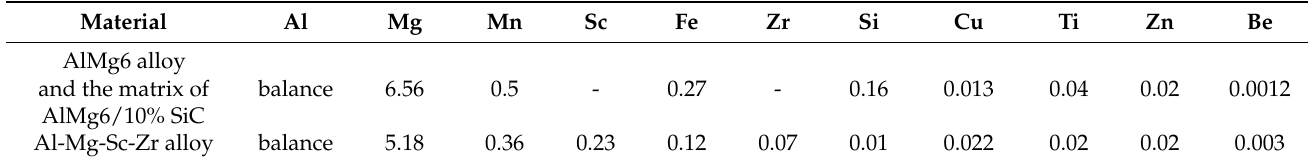
Table 2. Chemical composition of materials,